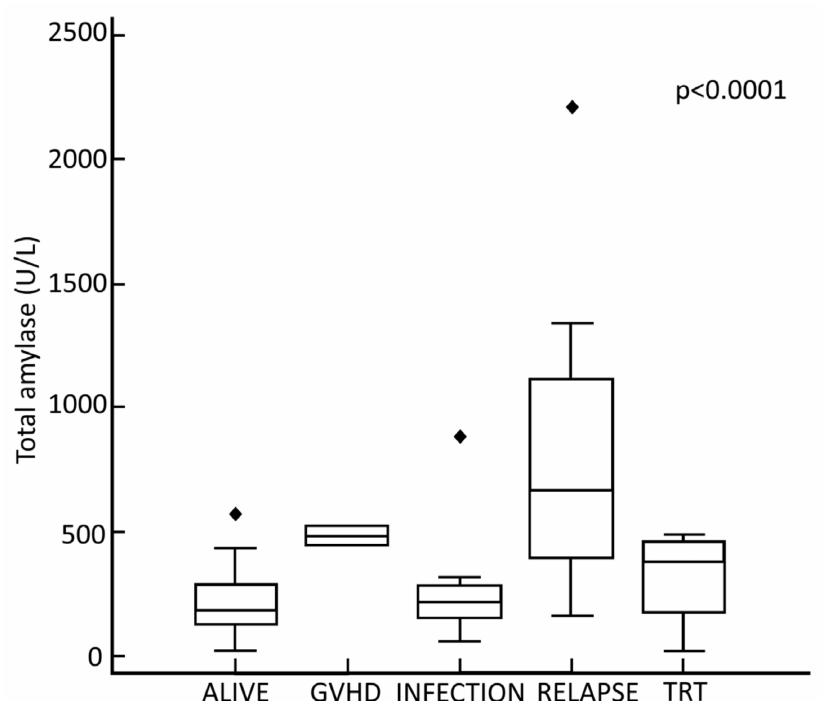
Figure 3. Box-and-whisker plot of maximum total amylase concentration in patients with different transplant-related outcomes. Box plots showing the median (line), upper and lower quartiles (box), and 5% and 95% limits (lines extending from the box). The outcomes are shown on the x-axis. From left to right of the axis, the following categories apply: surviving patients, dead of graft-versus-host disease (GVHD), dead of infection, dead of leukemia relapse, dead of transplant-related toxicity (TRT). The highest TA value was observed in the group of patients who died from a leukemic relapse (673 U/L), followed by death due to GVHD (490 U/L) and by transplant-related organ toxicity (386 U/L). The lowest TA value was detected in the group of patients who died from infectious complications (215 U/L). A Kruskal–Wallis test confirmed the significant difference in TA values of confronted groups ( p <